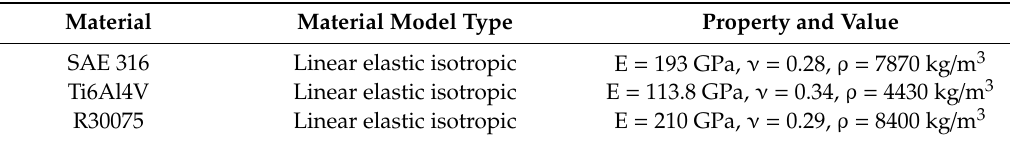
Table 1. Applicator proposed materials, material model type, mechanical and physical properties.